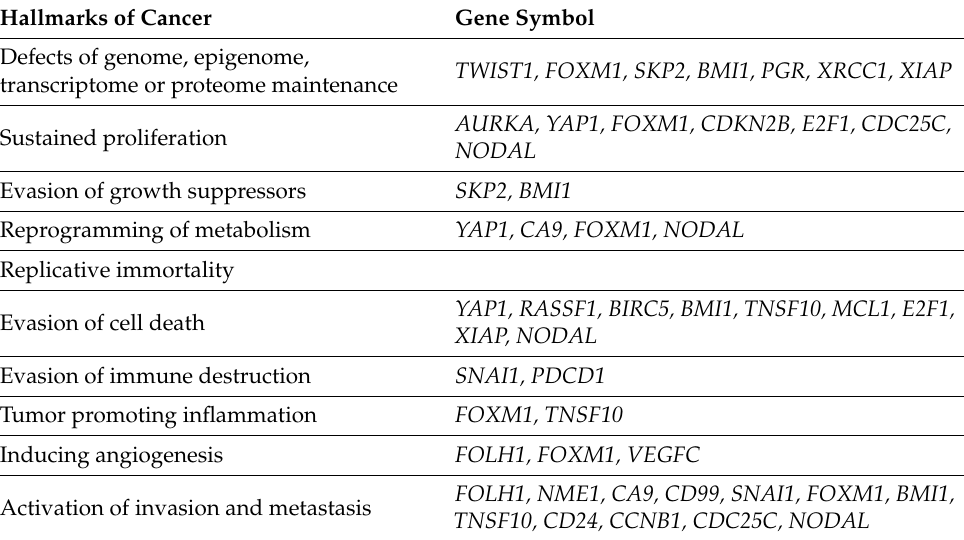
Table 1. Assignment of cancer genes with high CA t values to key cellular processes of